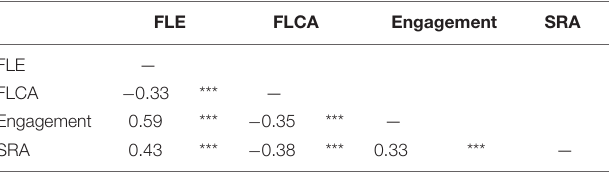
TABLE 2 | The bivariate correlations between achievement emotions, behavioral engagement, and self-reported